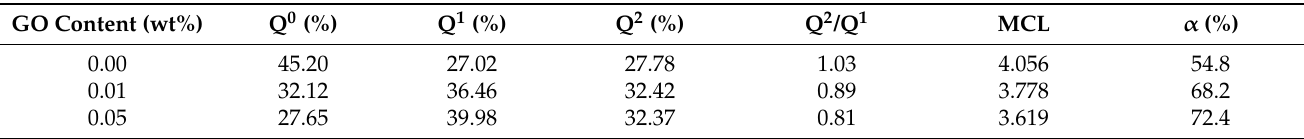
Table 1. Results obtained from 29 Si MAS NMR spectroscopy. Reprinted with permission from Ref. [101]. Copyright 2019 Elsevier. GO Content